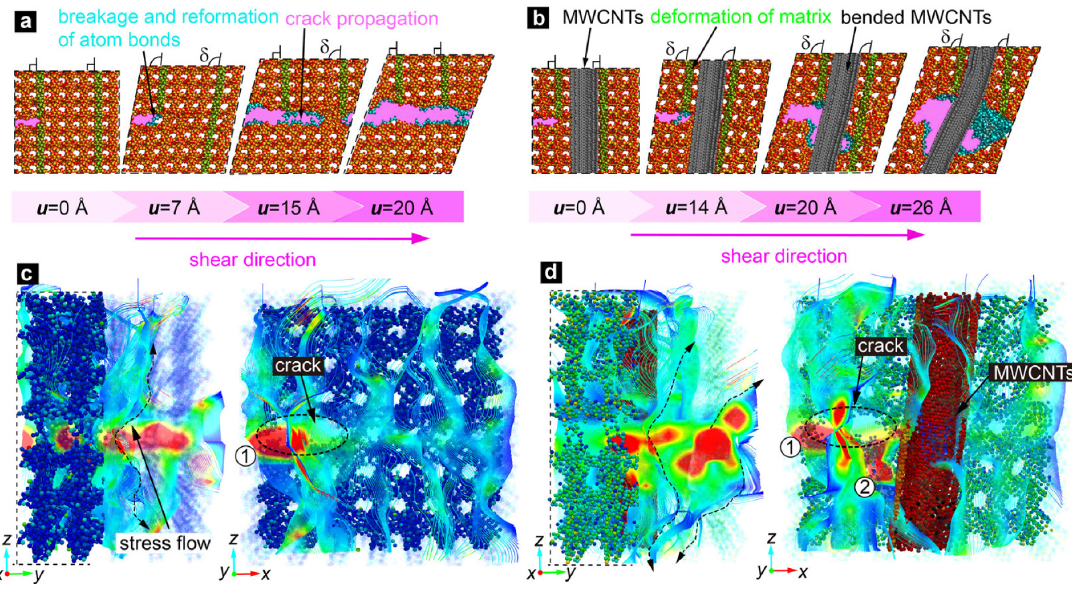
Figure 14: Nanoscale fracturing process of simulated cement matrices under shearing: (a) without MWCNTs; (b) with MWCNTs; (c), (d) the internal stress distributions [125]